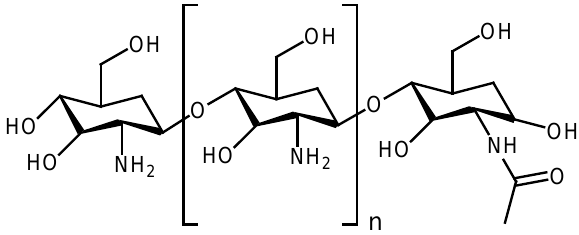
Figure 4. Molecular structure of chitosan.